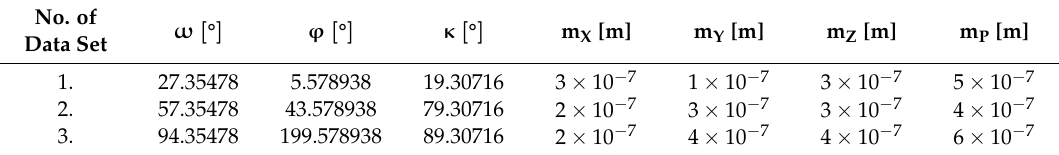
Table 7. Mean error (standard deviation) for example laboratory data